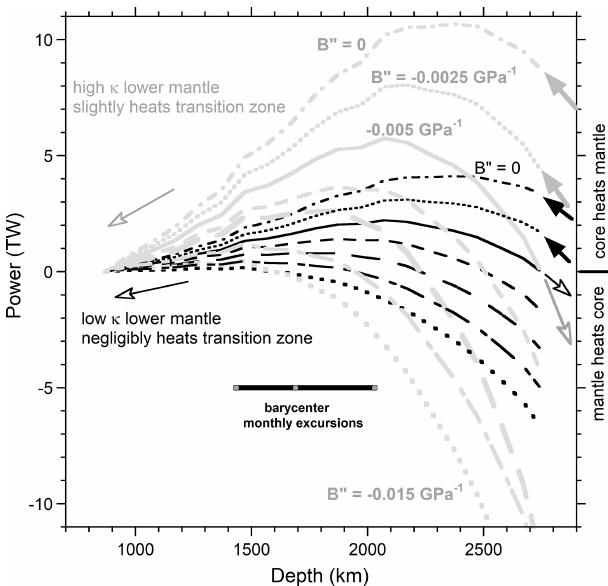
Figure 10. Power calculated from the flux curves in Fig. 9 and Eq. (15). Positive power is associated with temperature increas- ing inwards. Arrows indicate the direction of flow across the core– mantle boundary region and also into the